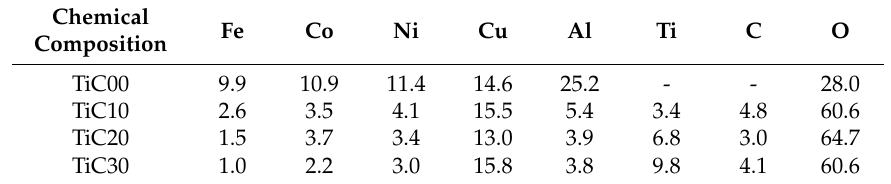
Table 4. Chemical compositions of the surface wear-tested at high temperature, in atomic percentage. Chemical Fe Co Ni Cu Al Ti C O Composition TiC00 9.9